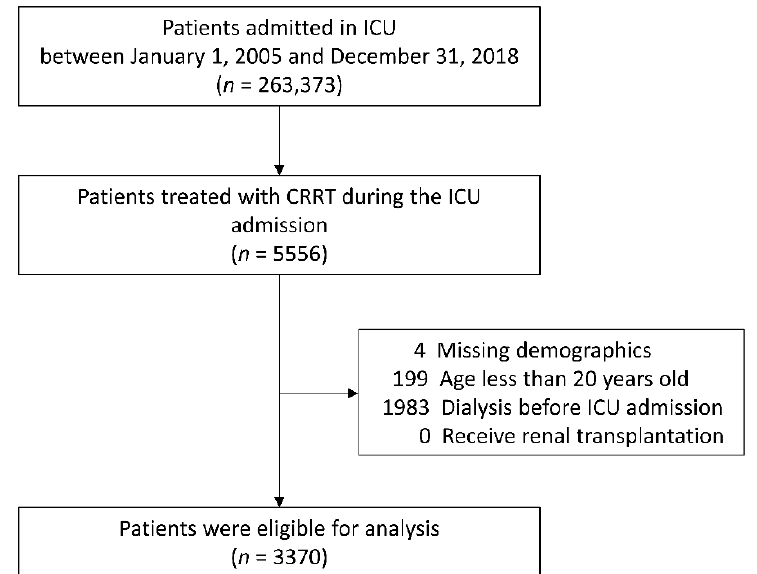
Figure 1. Flowchart of patient selection. ICU, intensive care unit; CRRT, continuous renal replace- ment therapy.